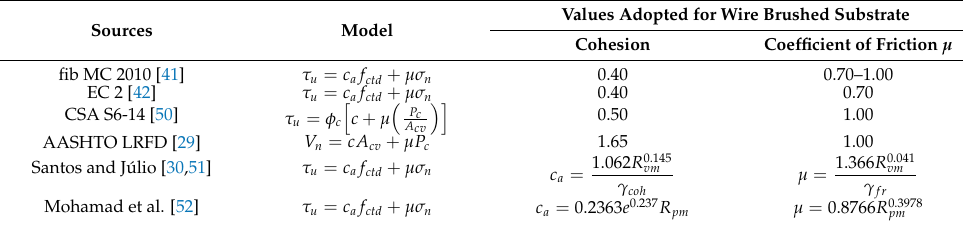
Table 8. Models for predicting bond strength between concretes.